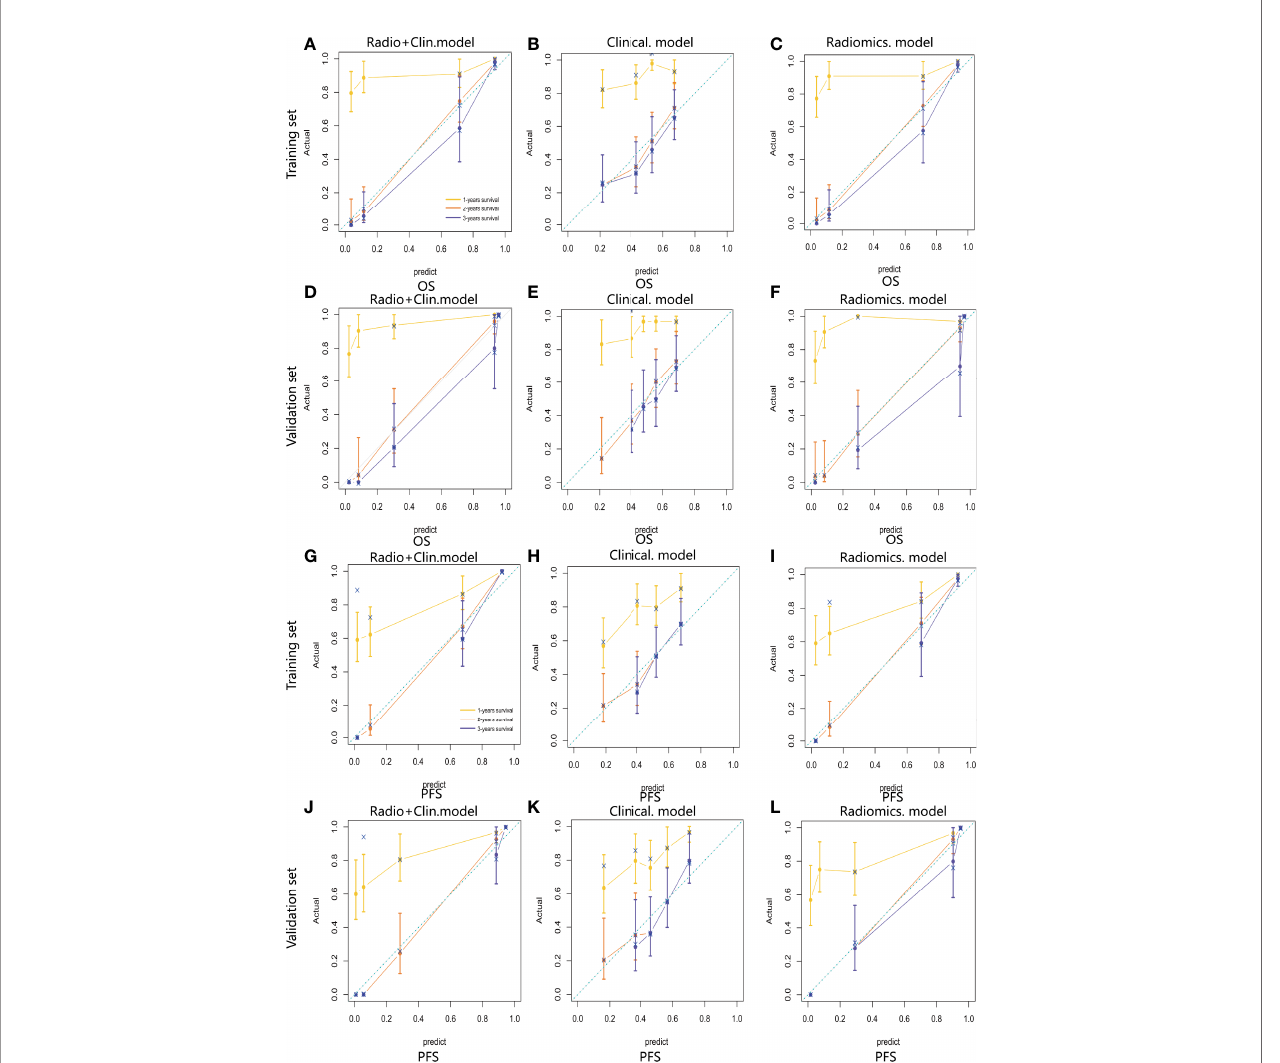
FIGURE 5 | Calibration curve of the integrated model (A) , radiomics model (B) and clinical model (C) for OS estimation in the training set. Calibration curve of the integrated model (D) , radiomics model (E) and clinical model (F) for OS estimation in the validation set. Calibration curve of the integrated model (G) , radiomics model (H) and clinical model (I) for PFS estimation in the training set. Calibration curve of the integrated model (J) , radiomics model (K) and clinical model (L) for PFS estimation in the validation